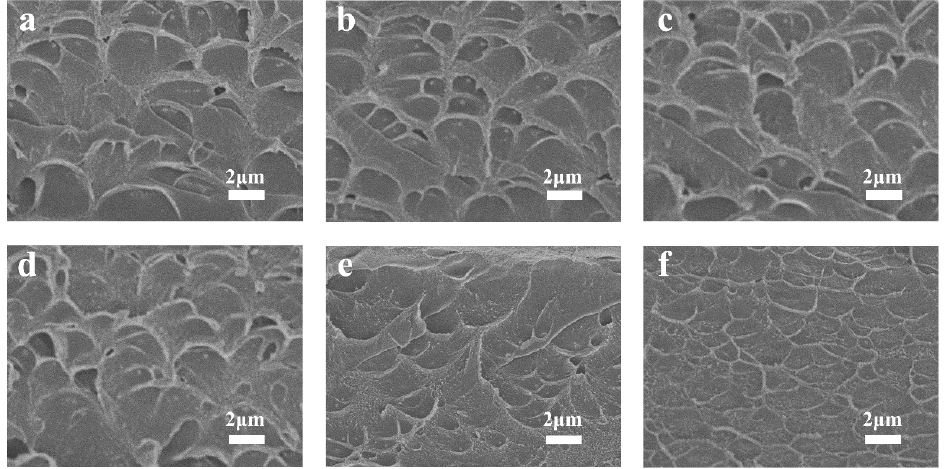
Figure 2. The cross-section SEM of AmPBI and AmPBI-MOE-PIL-X (X = 0%, 5%, 10%, 20%, 30%) membranes ( a – f ).